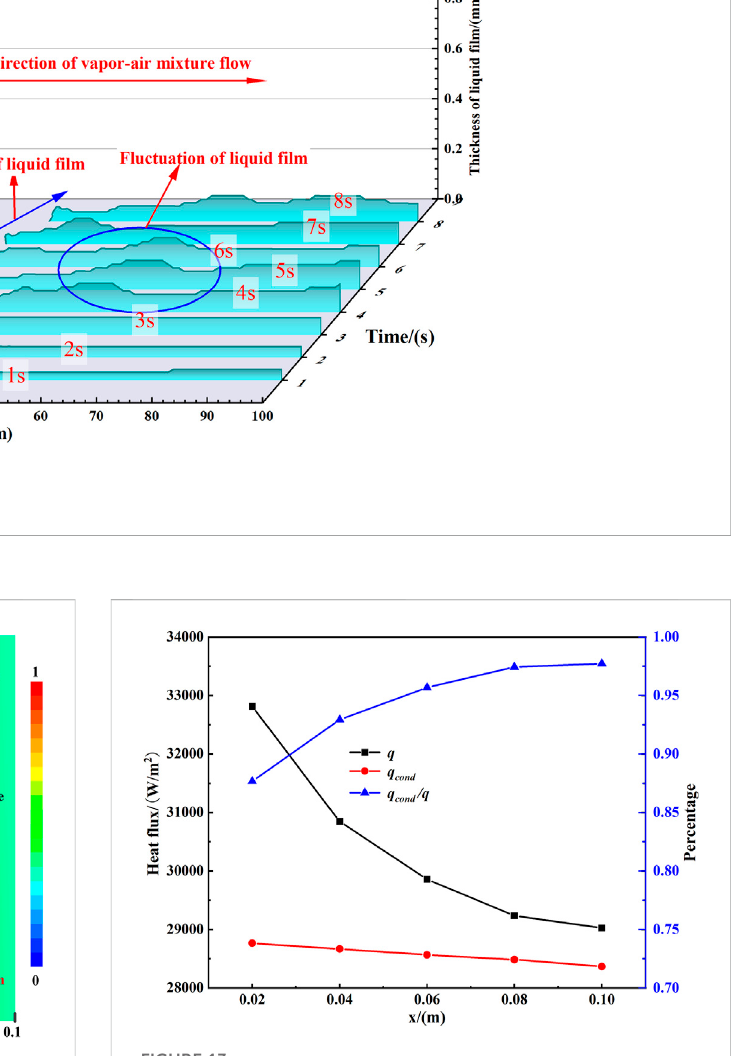
FIGURE 13 Wall heat fl ux in mixture gas fl ow direction in Case